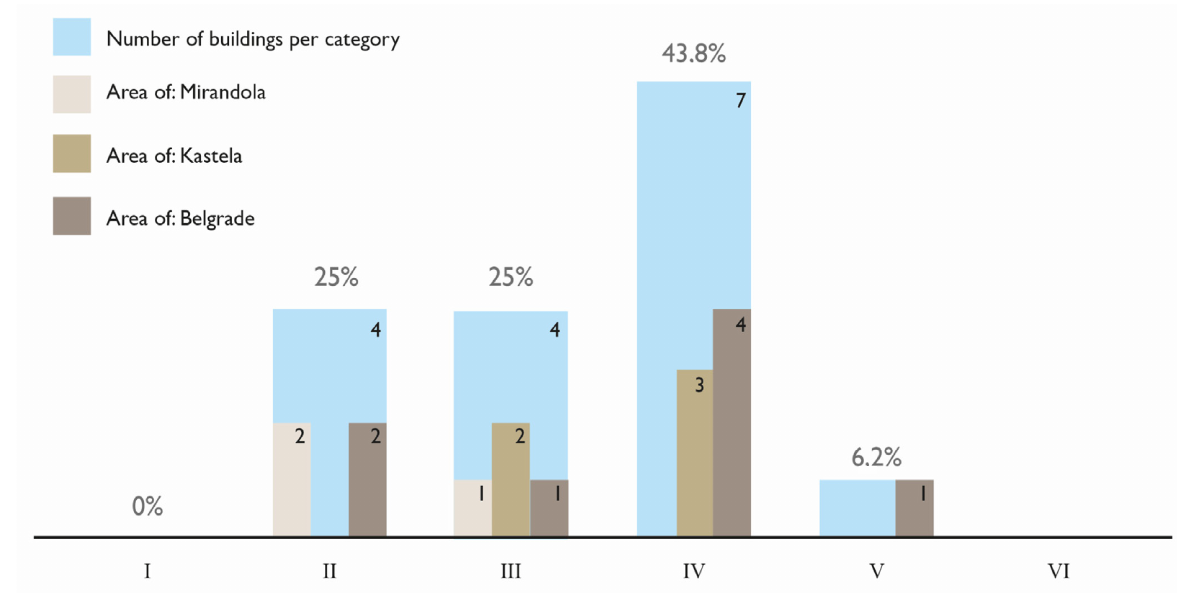
Figure 12. The index of structural response for the three study